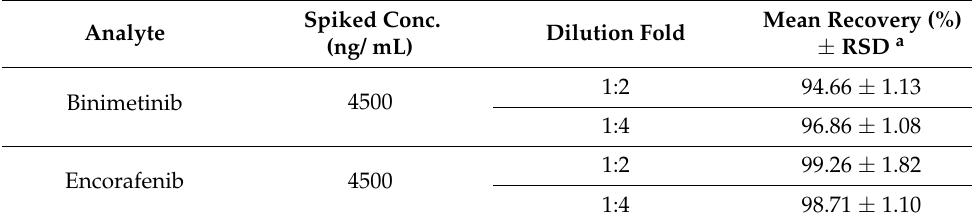
Table 5. Evaluation of the dilution integrity of binimetinib and encorafenib in rat plasma. Mean Recovery (%) Spiked Conc. Dilution Fold Analyte ± RSD a (ng/ mL) 1:2 94.66 ± 1.13 Binimetinib 4500 1:4 96.86 ± 1.08 1:2 99.26 ± 1.82 Encorafenib 4500 1:4 98.71 ± 1.10 a Mean recovery (%) ± RSD of six determinations.